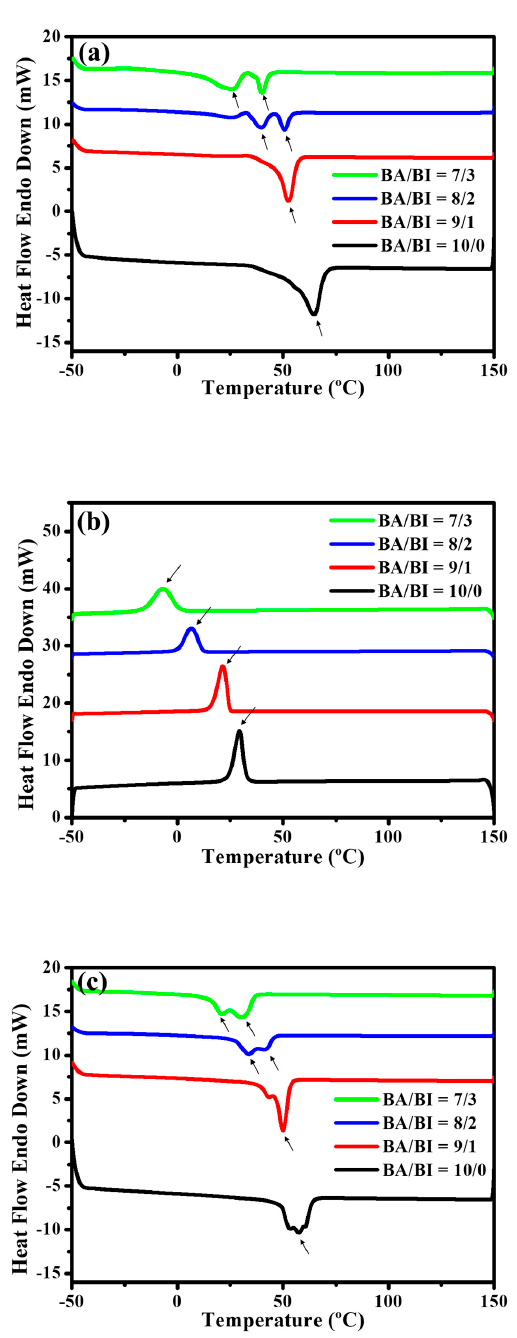
Figure 3. Differential Scanning Calorimetry (DSC) trace of the PBABI copolyesters. ( a ) Heating curves in the first cycle, ( b ) cooling curves in the first cycle, and ( c ) heating curves in the second cycle.